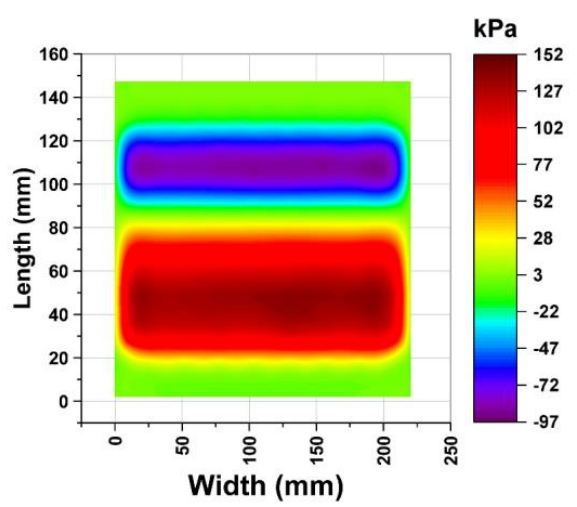
Figure 9. Longitudinal stress projection.